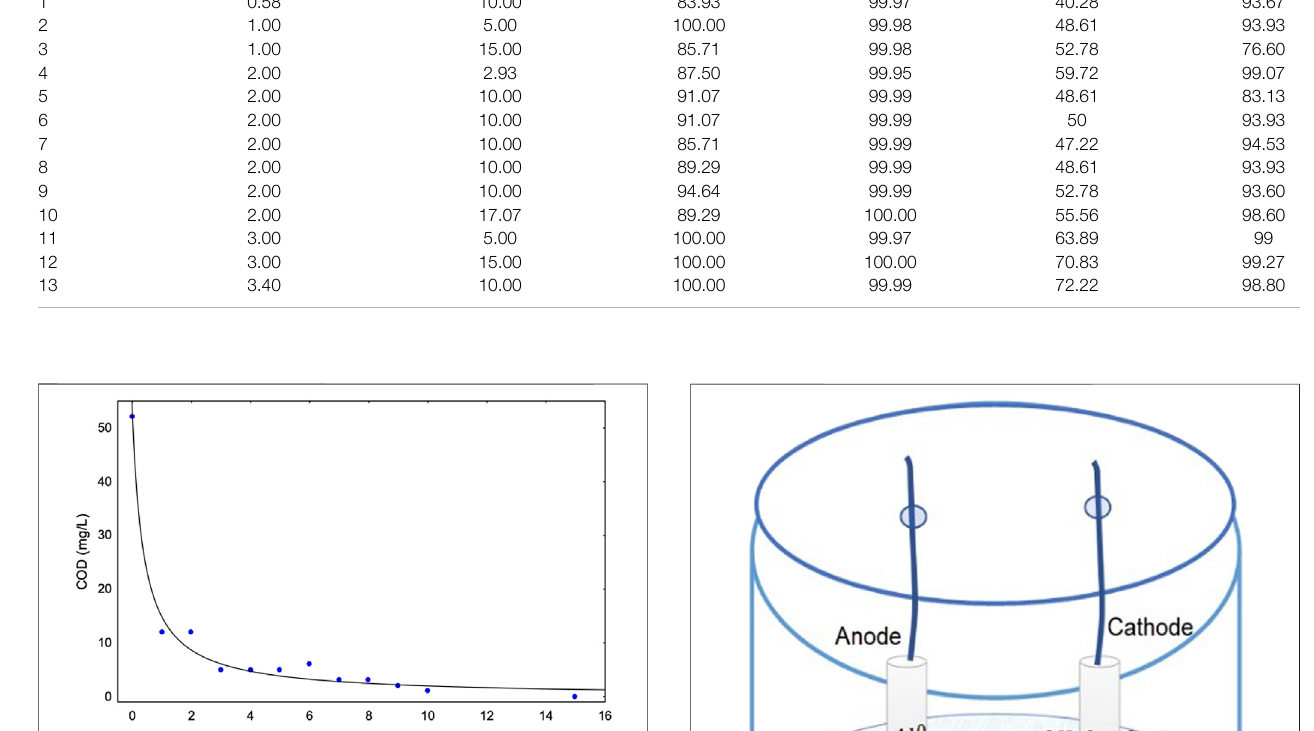
TABLE 3 | Experimental design: response surface methodology (RSM) central composite design (CCD) for COD and turbidity removal ef fi ciency. Run Real values % Removal Sea salt Sodium sulfate Current density (mA/cm 2